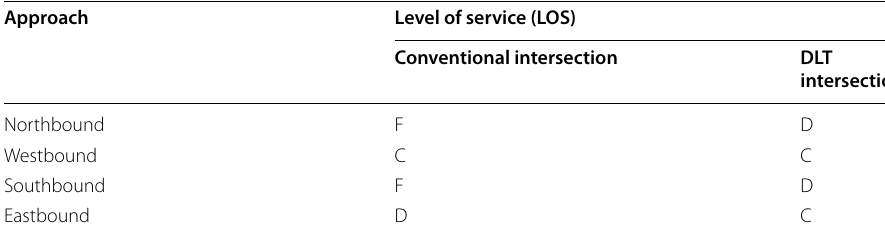
Table 4 Level of service (LOS) for conventional intersection and DLT intersection Approach